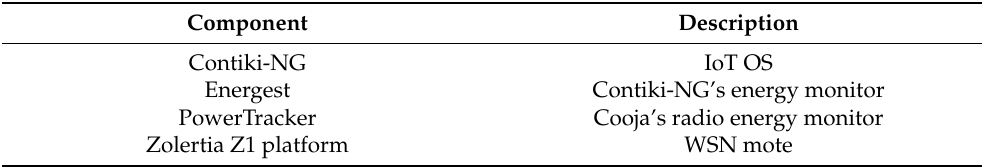
Table 2. Experimental environment used with Cooja.